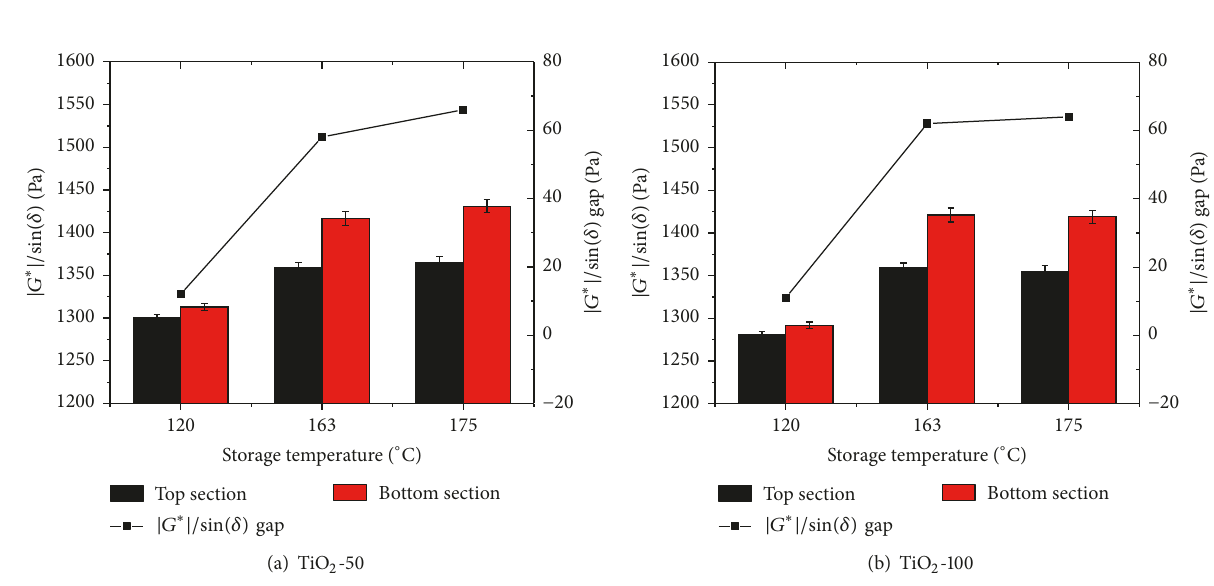
Figure 8: The effects of storage temperature on |𝐺 ∗ |/ sin (𝛿)